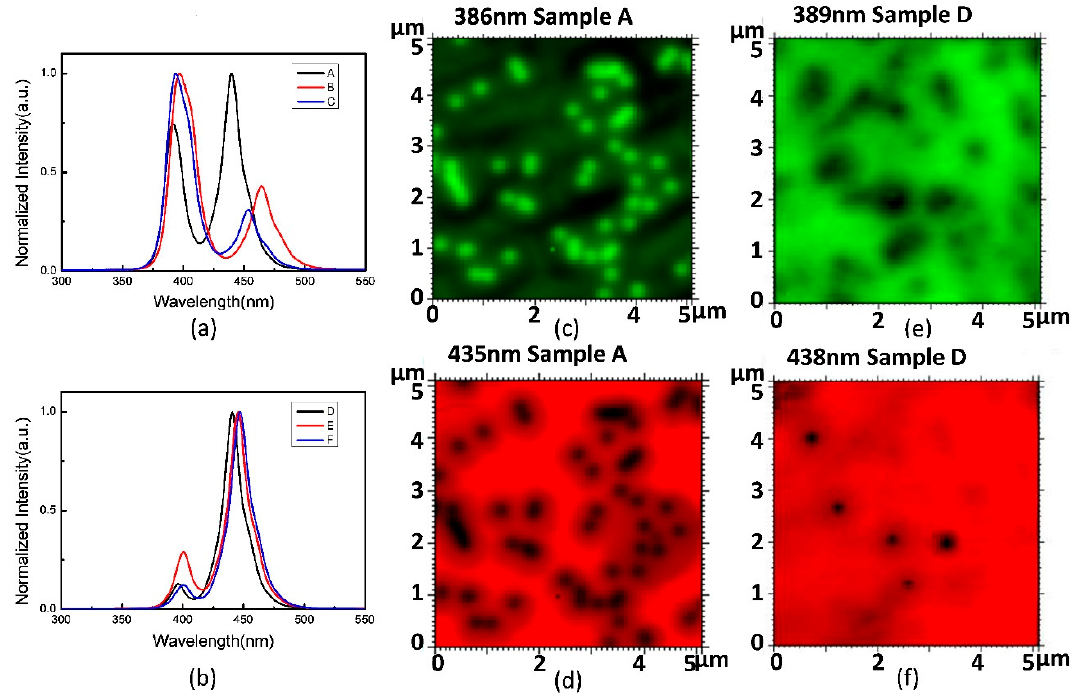
Figure 4. CL spectra of samples ( a ) A/B/C and ( b ) D/E/F measured at 10 K. Spatial distribution of CL spectral bands of sample A at ( c ) 386 and ( d ) 435 nm. Spatial distribution of CL spectral bands of sample D at ( e ) 389 and ( f ) 438 nm.